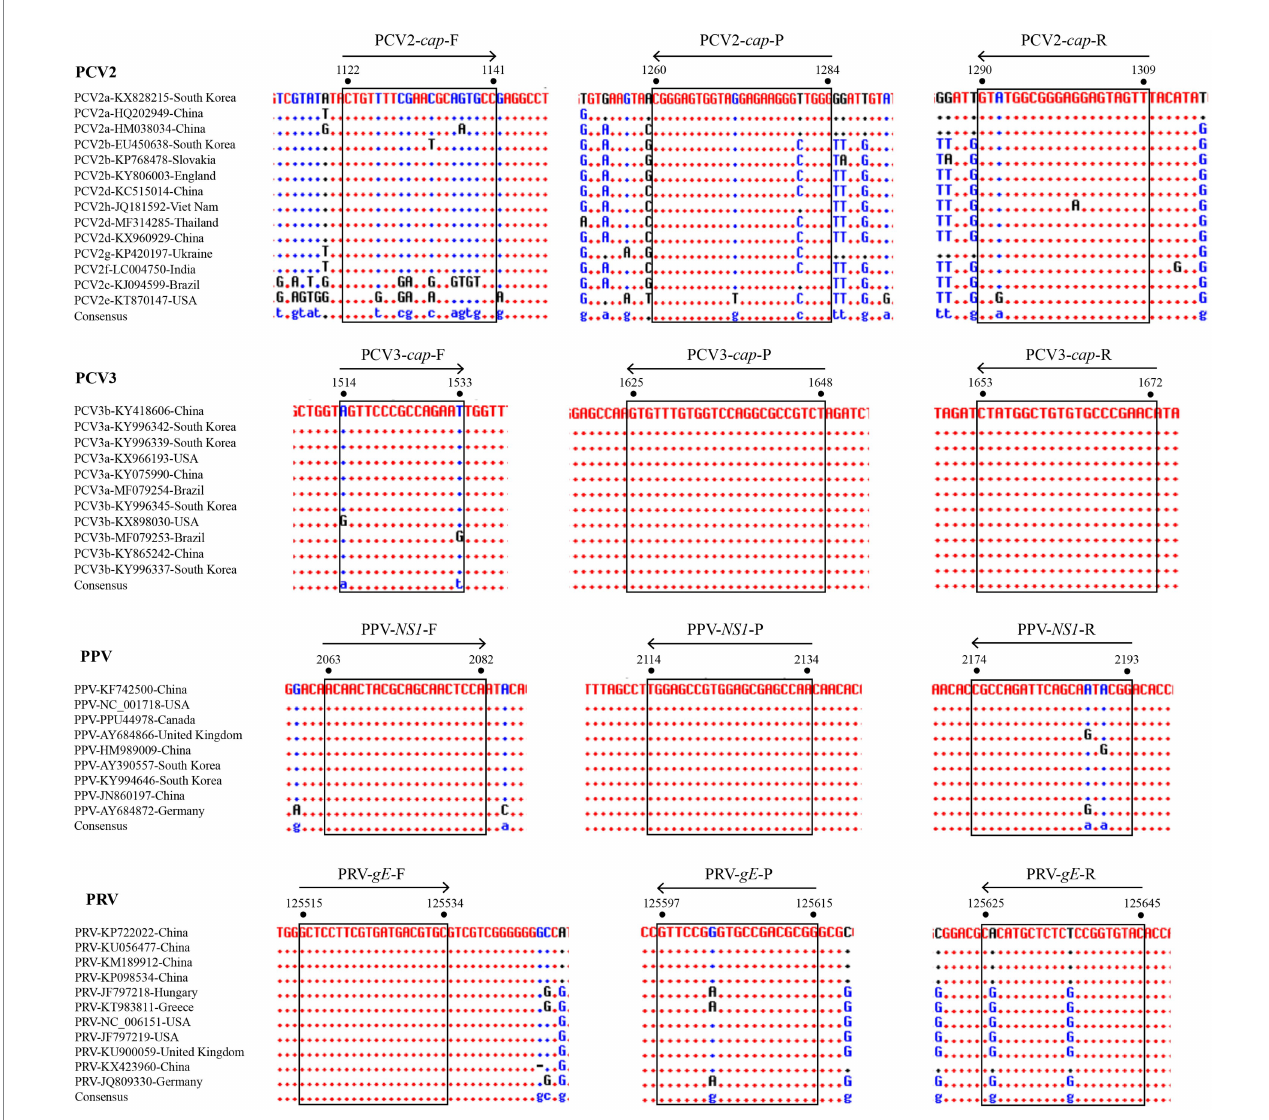
FIGURE 1 Alignments of coding sequences of reference viral strains deposited in GenBank. The locations of the primers/probes specific for PCV2 cap gene, PCV3 cap gene, PPV NS1 gene, and PRV gE gene are shown. The positions of the partial nucleotide fragments are indicated by